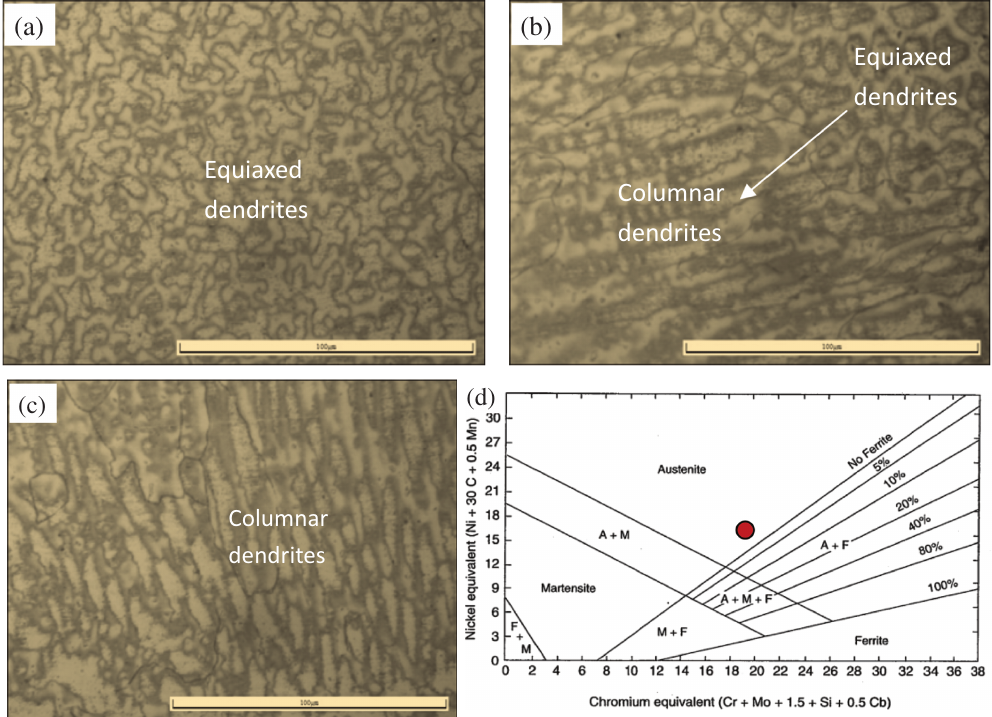
Figure 3: Microstructures of the weld metal (a) equiaxed dendrites with a grain size of 10 µm, (b) mixture of equiaxed dendrites and columnar dendrites, (c) columnar dendrites, (d) Schaeffer diagram.